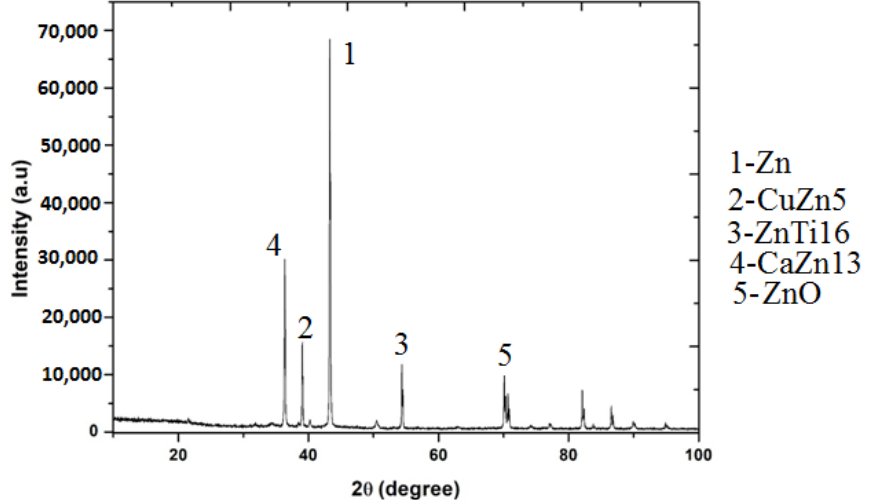
Figure 3. XRD: biodegradable zinc alloy.